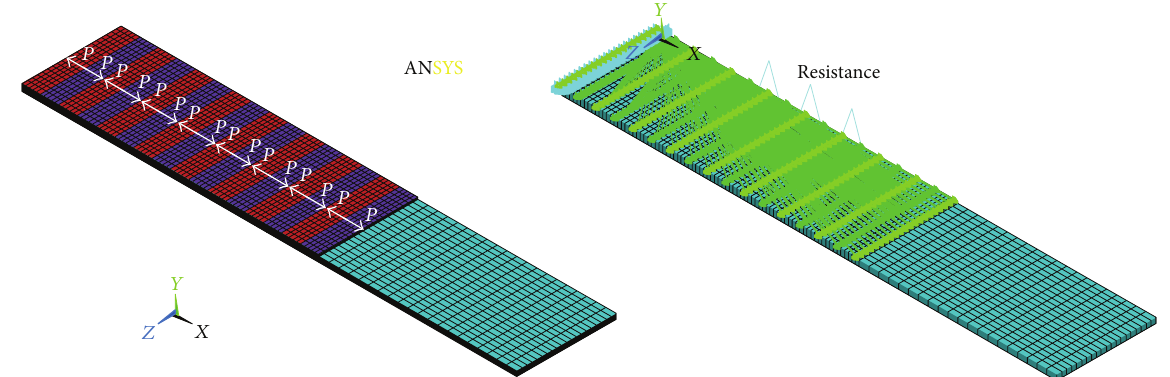
Figure 6: FE electromechanical model of the EH for 𝑁 = 17 electrodes (P: poling direction).